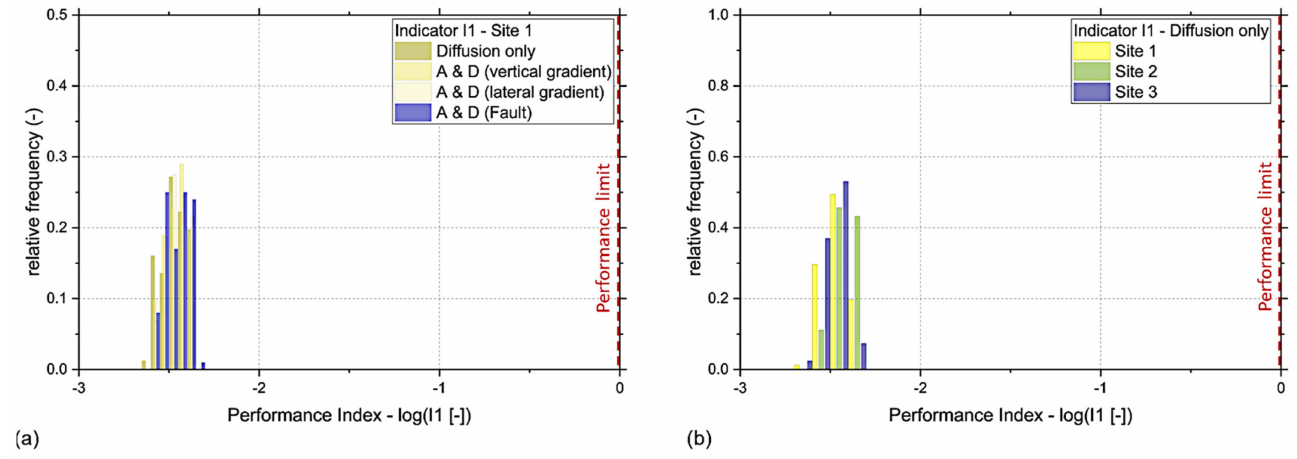
Figure 21. Comparison of performance envelope of performance index I1: ( a ) for different scenarios at one siting region; ( b ) between three different sites resp. siting